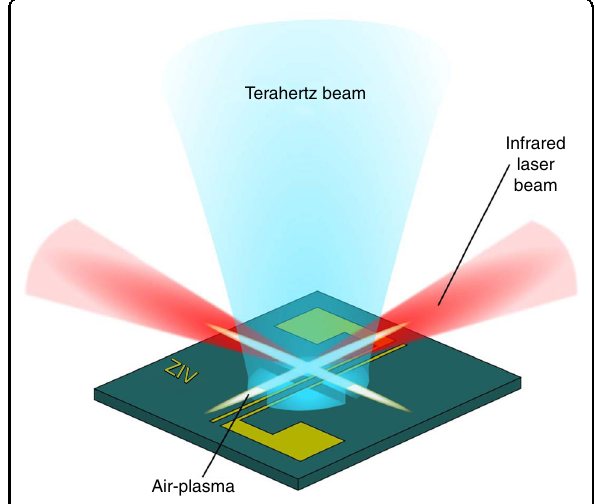
Fig. 1 Schematic of the two crossing plasma fi laments opening up a dynamic aperture for terahertz near- fi eld